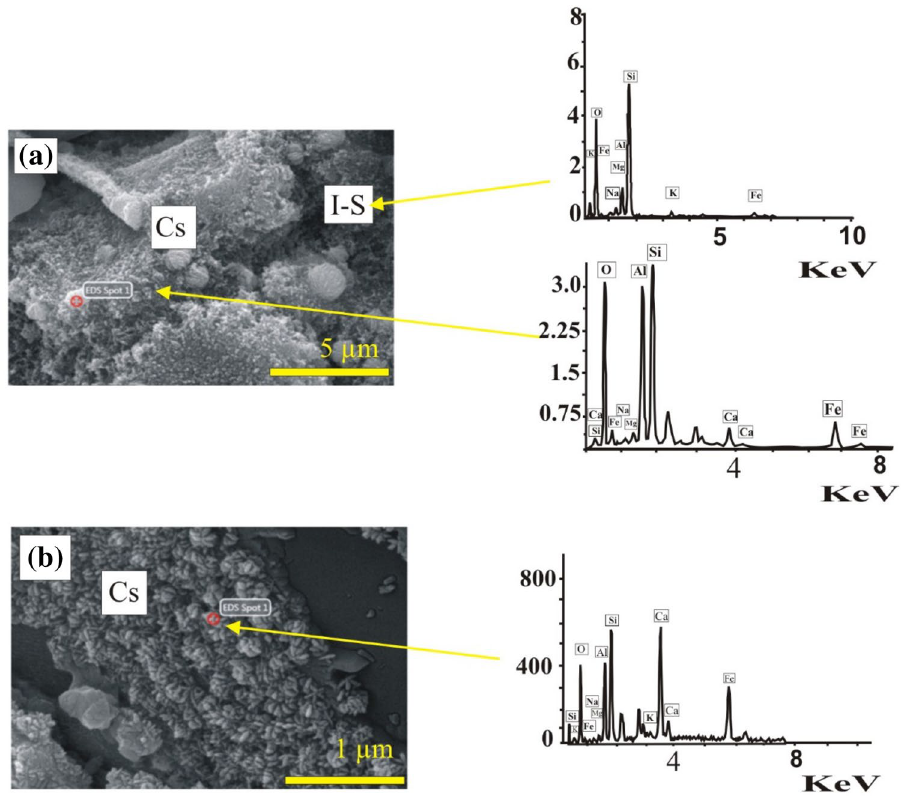
Fig. 8 Representative SEM micrographs and EDS traces for Haymana sandstones samples a Diagenetic chlorite (Cs: chamosite) and mixed-layer smectite–illite (I-S) minerals have observed as grain coating mostly. b Diagenetic chlorite minerals have observed as grain coating mostly. The chlorite is an iron-rich. The Lithofacies A sandstones exhibit large pores with diameter 2–4 μm. Lithofa- cies A sandstones, L1 section, Sample number